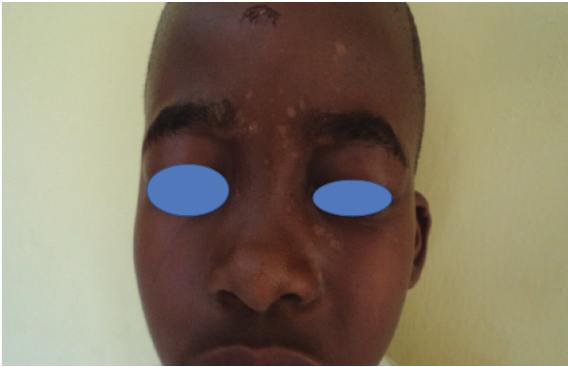
Figure 3: Pityriasis versicolor on the face.